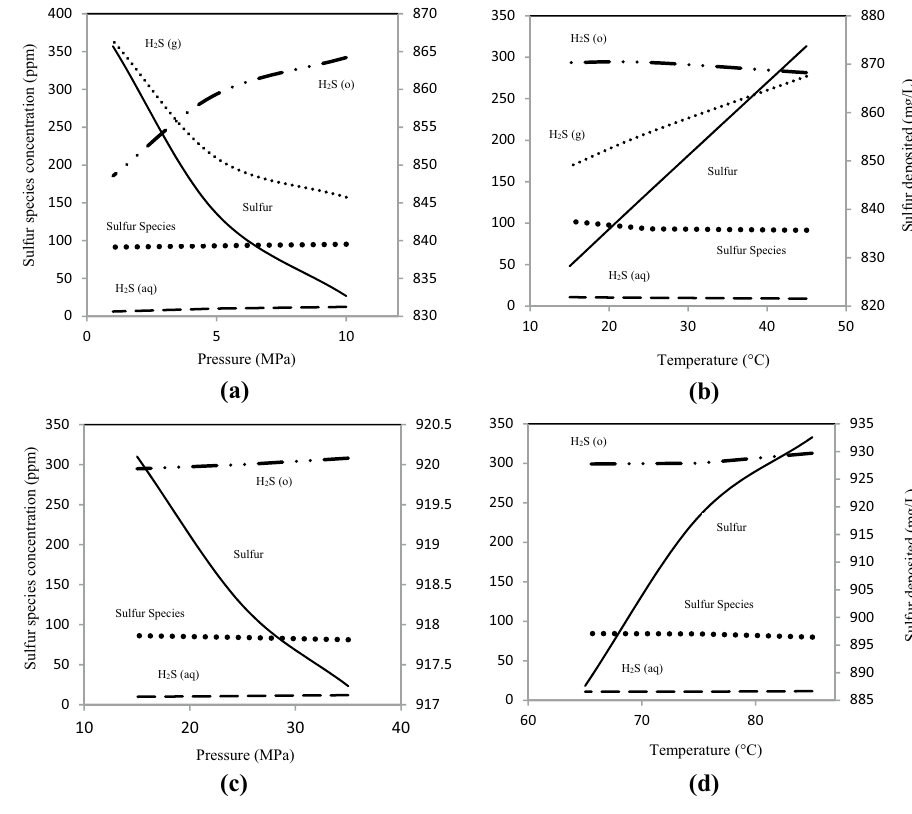
Fig. 1 The effects of tem- perature and pressure on sulfur speciation, solid-phase formation, and H 2 S partitioning, aqueous-phase reactions,